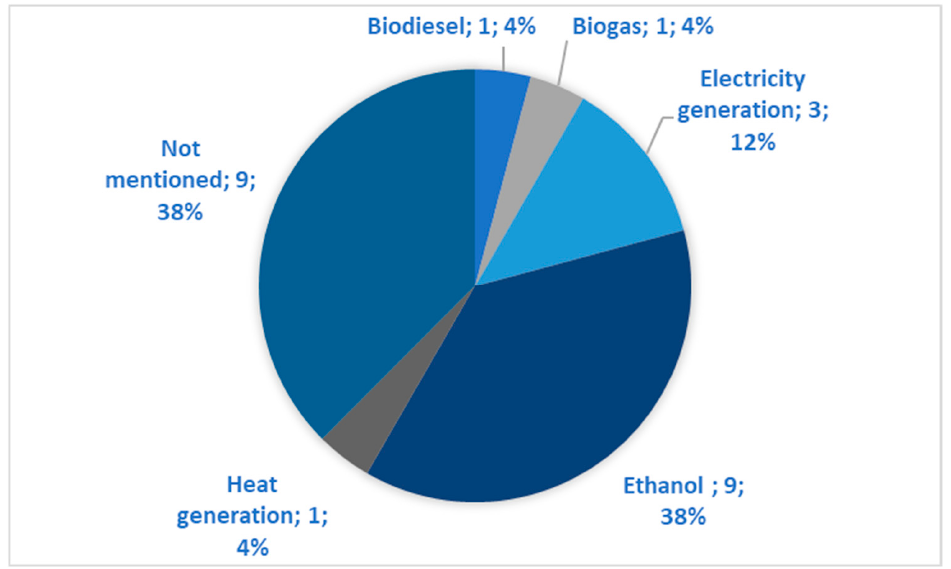
Figure 4. Number and share of studied articles according to the bioenergy use. Source: author’s elaboration.